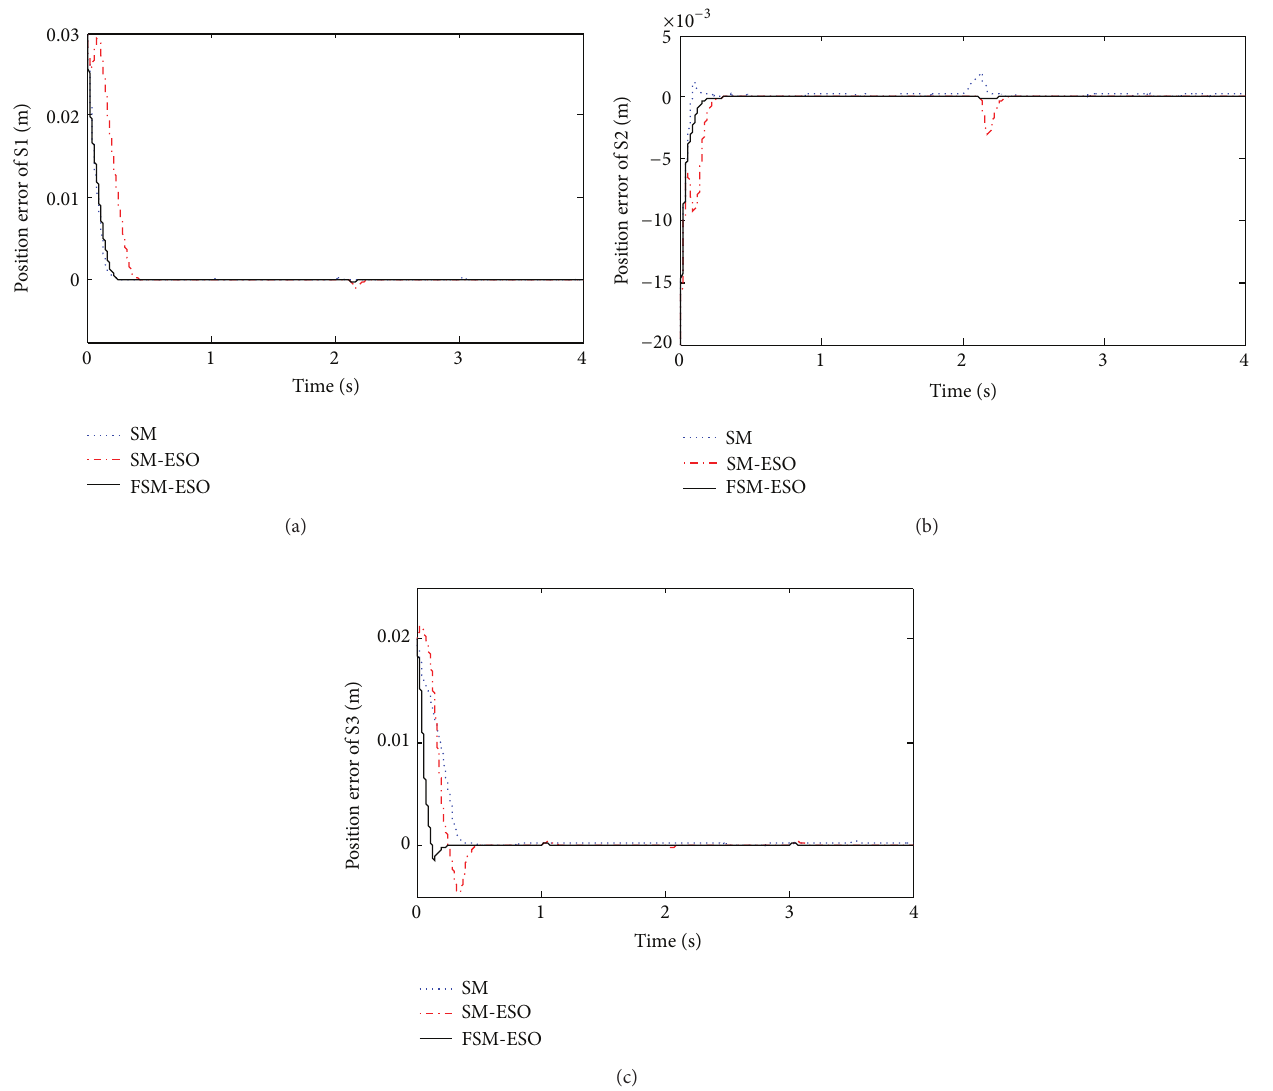
Figure 6: (a) Position tracking error of S1, (b) position tracking error of S2, and (c) position tracking error of S3.